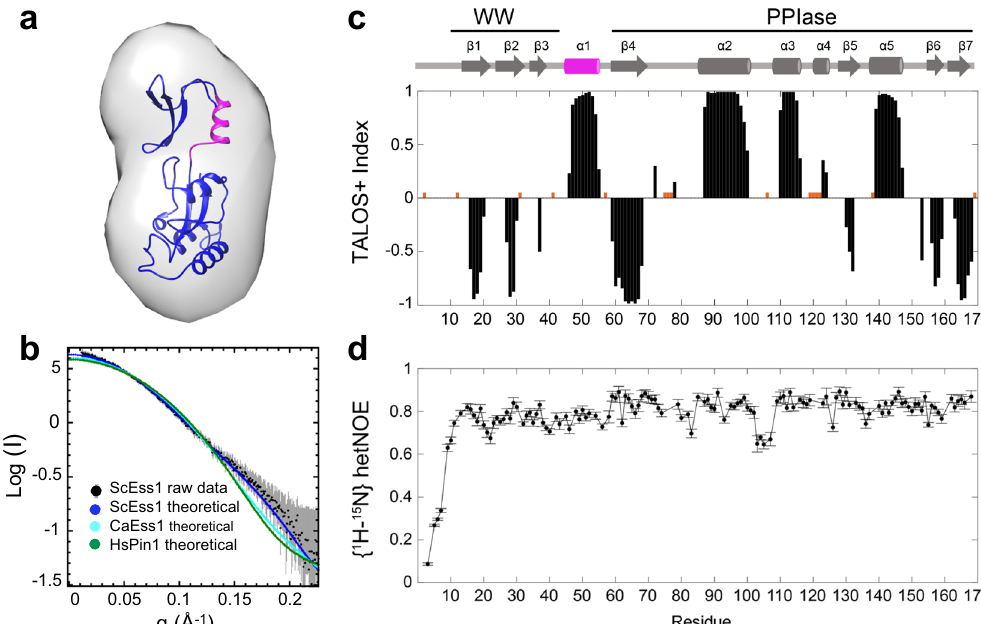
Fig. 2 SAXS and NMR data show Ess1 is elongated, and fully ordered in solution, including the linker. a The Ab initio small angle X-ray scattering (SAXS) envelope overlaid with the crystal structure. Envelope is contoured at 20 Å resolution. b Scattering pro fi le of ScEss1 at 4.78 mg/mL (black points; gray error bars) was used for comparison of SAXS pro fi les predicted from the crystal structures of HsPin1 (green points), CaEss1 (cyan points), and ScEss1 (blue points) in the program Crysol (ATSAS package, EMBL). The Chi values for each of these fi ts to the raw data are as follows: 1.467 (HsPin1), 0.959 (CaEss1), and 0.209 (ScEss1), indicating the best fi t for the ScEss1 structure. c TALOS + secondary structure calculation using NMR backbone HN, N, CO, CA, and sidechain CB chemical shift assignments. TALOS con fi rms the α -helical structure of linker (residues 46 – 59 in pink). d Backbone 1 H – 15 N heteronuclear NOEs show that the protein is well-structured throughout the WW and PPIase domains, including the linker region. Errors in NOEs were determined using standard error propagation (see the “ Methods ”